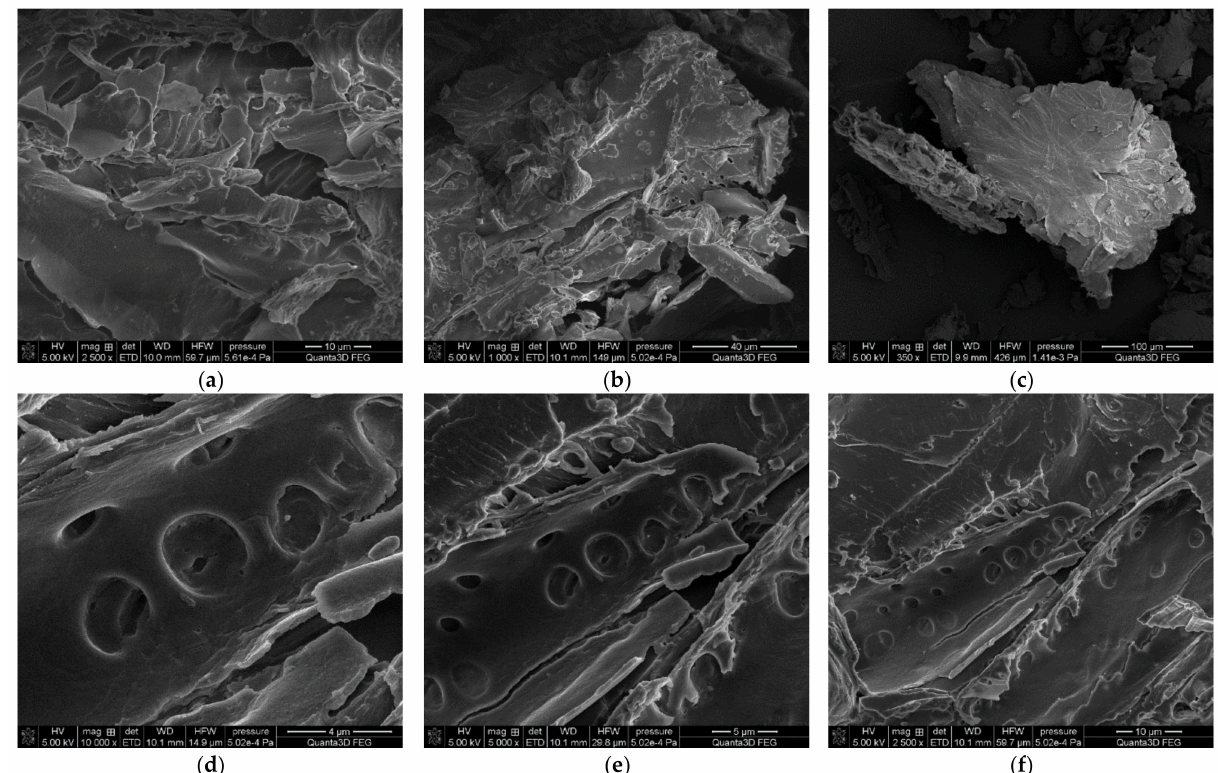
Figure 1. Scanning electron micrographs of the peanut shell powder; ( a – c ) SEM images of peanuts shell powder (magnifica- tion 350–2500 × ). ( d – f ) peanuts shell powder (magnification 2500–10,000 ×